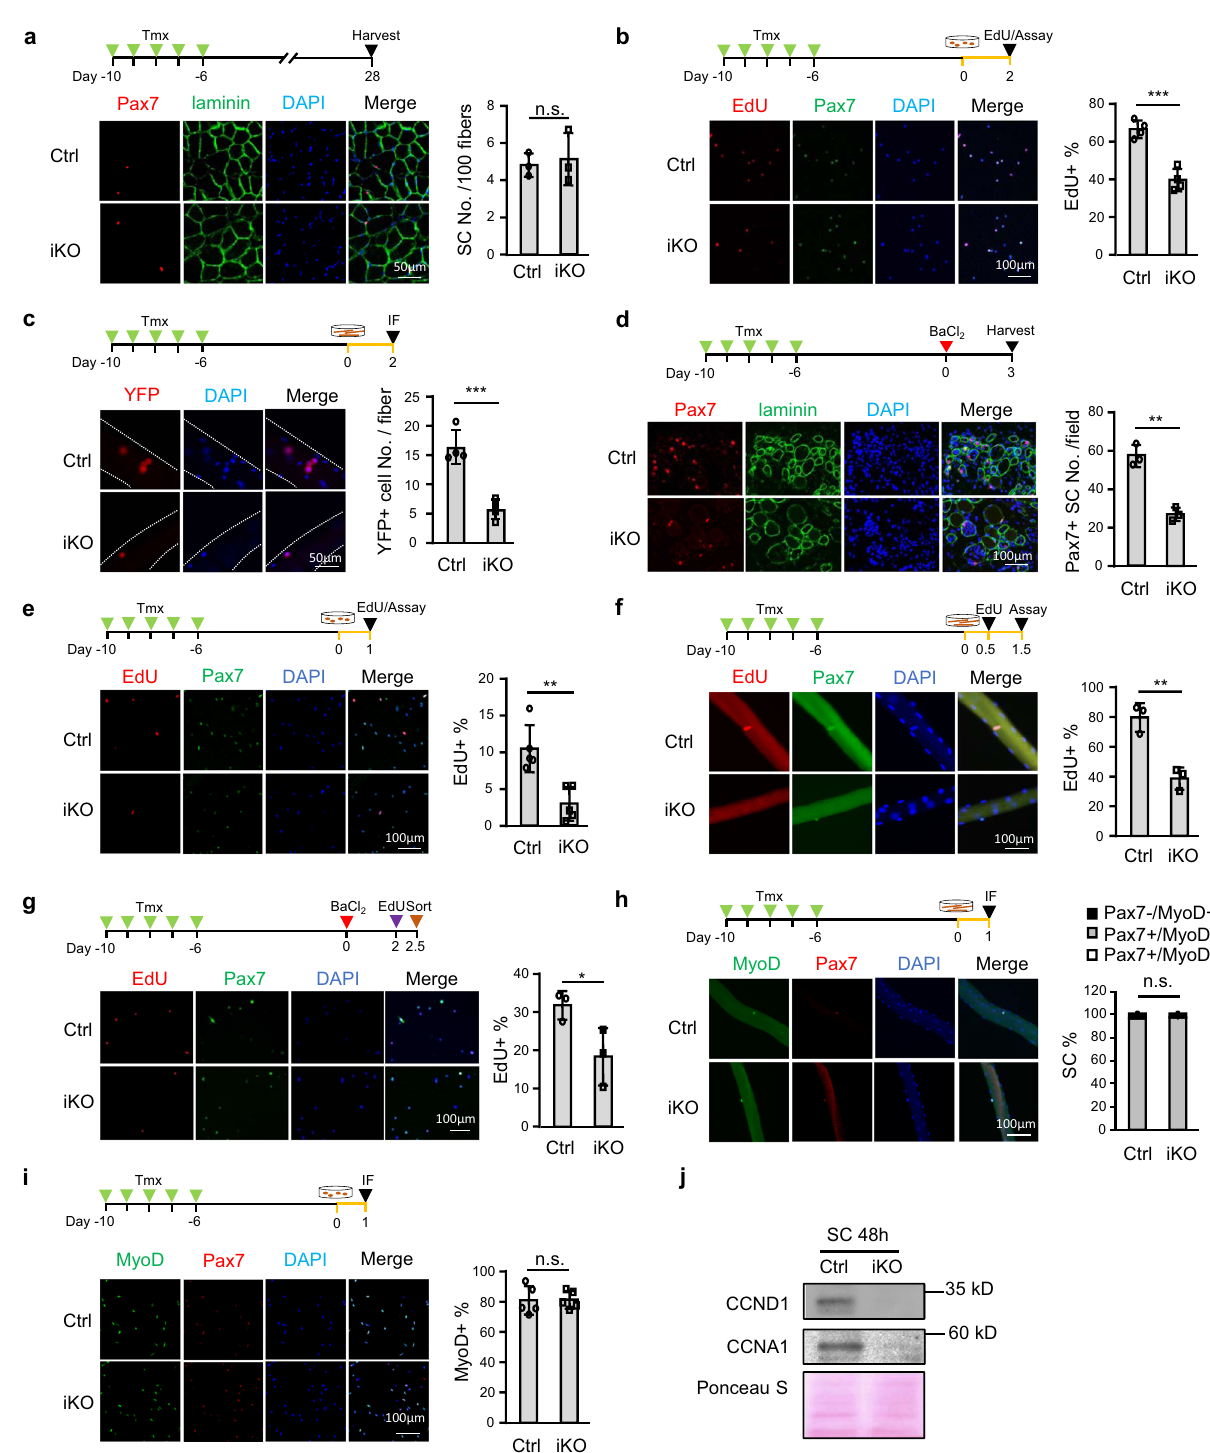
isolation revealed that nearly all SCs were MyoD + in both Ctrl induced defect was not in cell cycle re-entry but rather in cell cycle and iKO myo fi bers (Fig. 3h), suggesting that quiescence exit was progression (Supplementary Fig. 2e). To con fi rm this, we deleted not affected by Dhx36 deletion. Further, after culturing freshly Dhx36 in C2C12 myoblasts by CRISPR-Cas9-mediated gene sorted SCs for 1 day, a similar percentage of Ctrl (81.0%) and iKO editing (Supplementary Fig. 2f). Indeed, homozygous deletion of (81.4%) SCs were MyoD + positive (Fig. 3i), and there was no Dhx36 reduced EdU incorporation by 46% as compared to Ctrl signi fi cant difference of MyoD expression at either mRNA or clones (Supplementary Fig. 2g). Further cell cycle analysis by FACS protein levels between Ctrl and iKO SCs (Supplementary Fig. 2c, d). revealed a severe G1 block in the KO cells after nocodazole Moreover, these myo fi bers had a similar percentage of Ki67 + SCs treatment (Supplementary Fig. 2h); consistently, the cycling genes (control, 94.4%; iKO, 93.4%), suggesting that the Dhx36 -KO- CCND1 and CCNA1 (which regulate the G1/S phase transition) NATURE COMMUNICATIONS| (2021) 12:5043